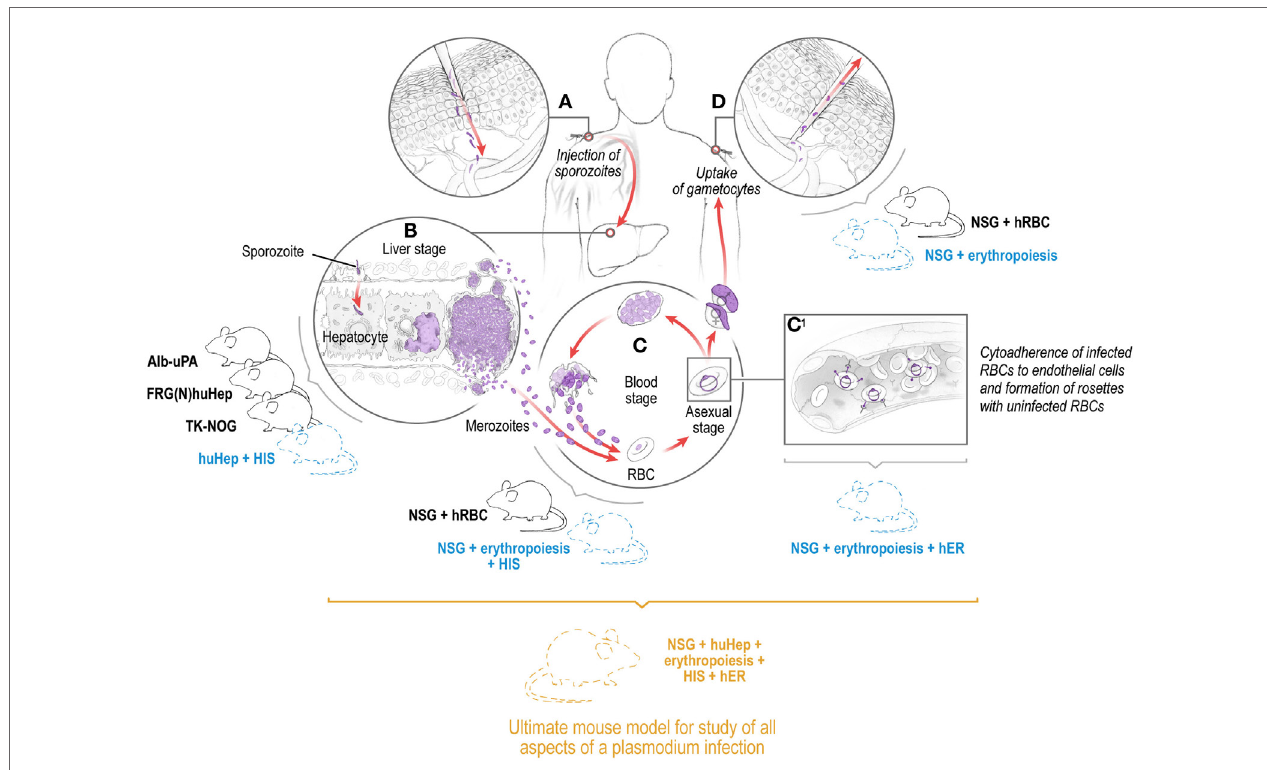
FiGURe 1 | Depiction of the Plasmodium life cycle in humans showing the skin, liver, and blood stages with the corresponding existing (solid lines) and future (dashed lines) humanized mouse systems to model each of the individual stages and eventually the full Plasmodium life cycle including pathology and transmission. Infection is initiated when a female Anopheles mosquito injects saliva-containing sporozoites into the skin. Sporozoites traverse dermal cells and gain access to the blood (A) . The highly motile sporozoites transit to the liver where each sporozoite infects a single hepatocyte (B) . One to two weeks after hepatocyte invasion, merozoites exit the liver and begin a 48-h cycle of red blood cell (RBC) invasion, replication, RBC rupture, and new merozoite release (C) . During RBC infection, the parasite expresses variant surface antigens on the surface of the infected red blood cell, which interacts with human endothelial receptors (hER), thus mediating the binding of infected RBCs to the microvascular endothelium of various organs (C 1 ) . A small number of blood-stage parasites differentiate into sexual gametocytes, which are taken up by mosquitoes in blood meals to continue the transmission to new human hosts (D)